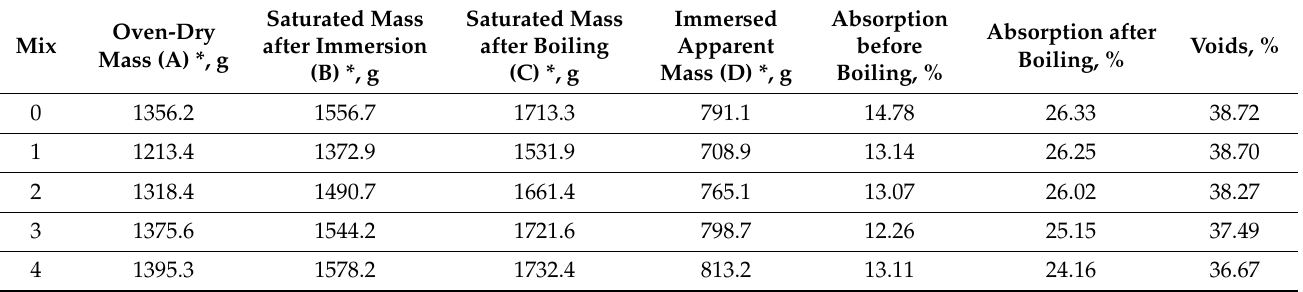
Table 7. Results of water absorption (cold and boiled) and voids (in volumetric %) for the different concrete mixtures (28-day cured